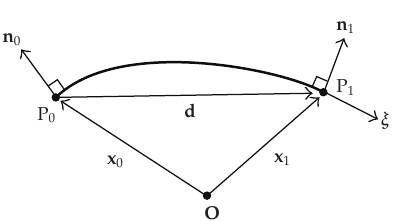
Figure 1: Interpolation of a curve segment on a